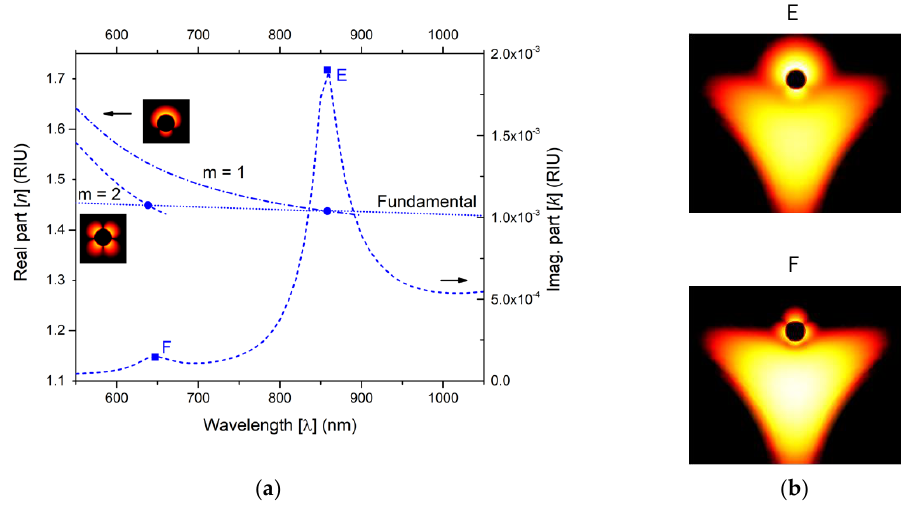
Figure 3. ( a ) RI real and imaginary part of the suspended core fiber sensing structure as function of wavelength for an external refractive index of 1.36. The crossing between the dispersion curves of the metal nanowire modes and the fundamental mode of the fiber are indicated by the circular dots and match the frequencies of the peaks (supermodes E and F), indicated by the squared dots. ( b ) Detailed distribution of the light intensity in the core and in the wire for the referred supermodes.